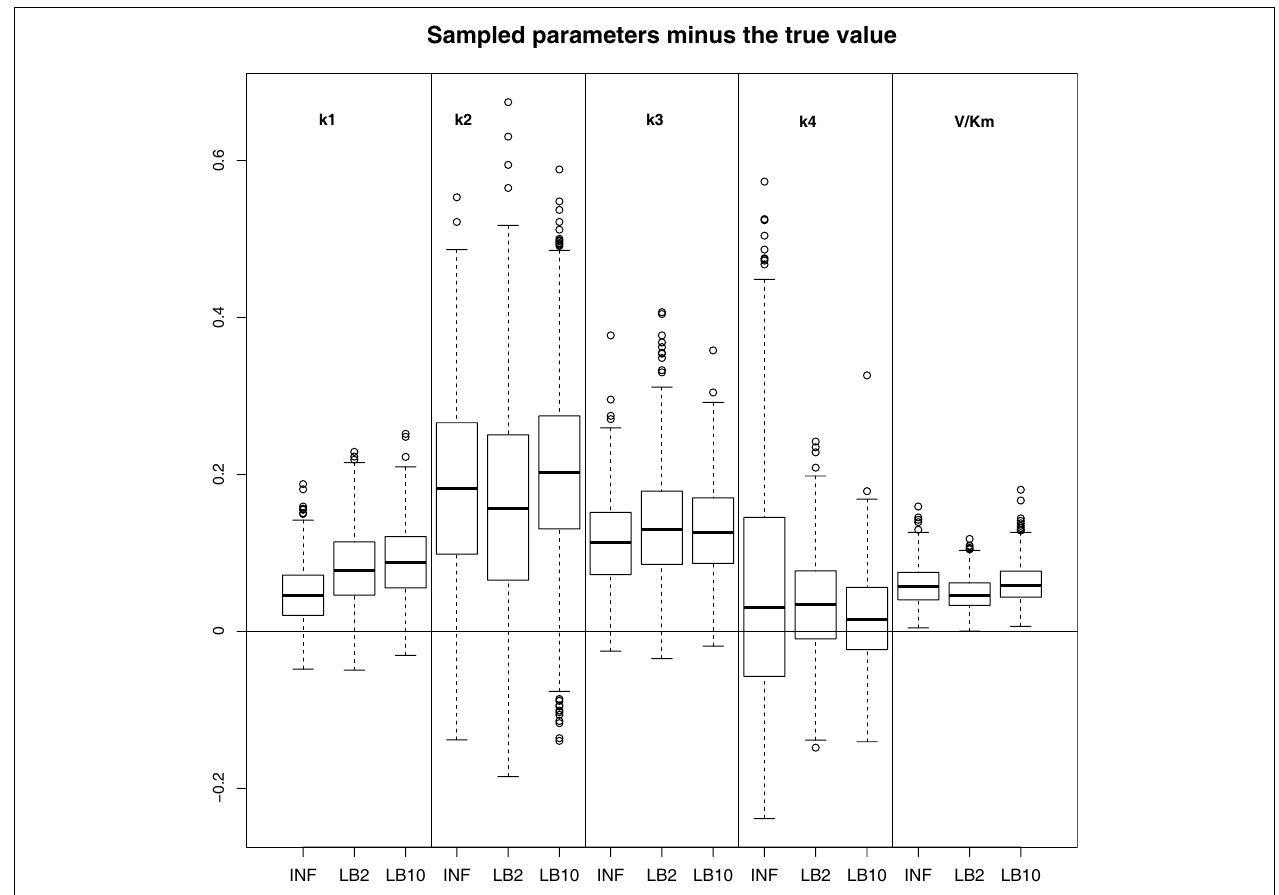
FIGURE 12 | Results from the dataset that showed the average RMS of the posterior parameter samples minus the true values for the INF, LB2, and LB10 methods . The posterior distributions are of the sampled parameters from equations (63)–(67) minus their true values. The horizontal line shows zero difference. For an explanation of the boxplot form, see the beginning of Section 6. Figure reconstructed from Macdonald and Husmeier (2015).